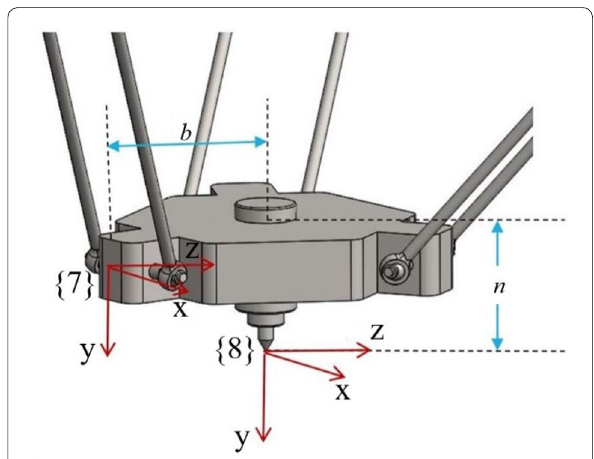
Figure 4 Frame assignment for the end effector and previous